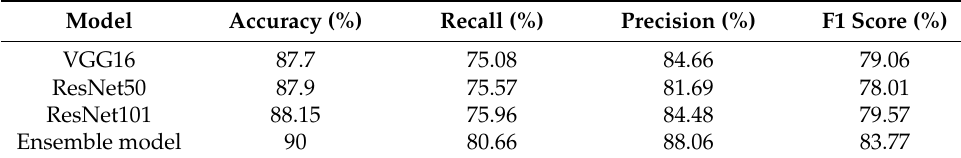
Table 3. Performance evaluation metrics of the three models.